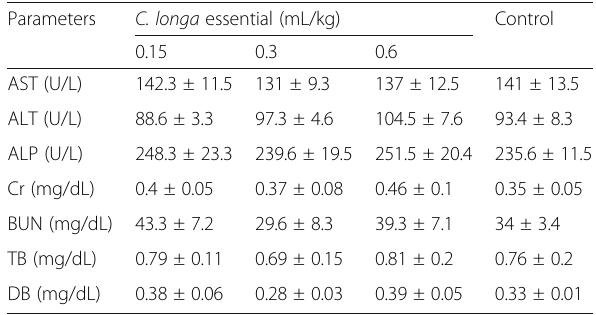
Table 3 Clinical chemistry parameters in mice sera following oral administration of C. longa essential oil for 2 weeks